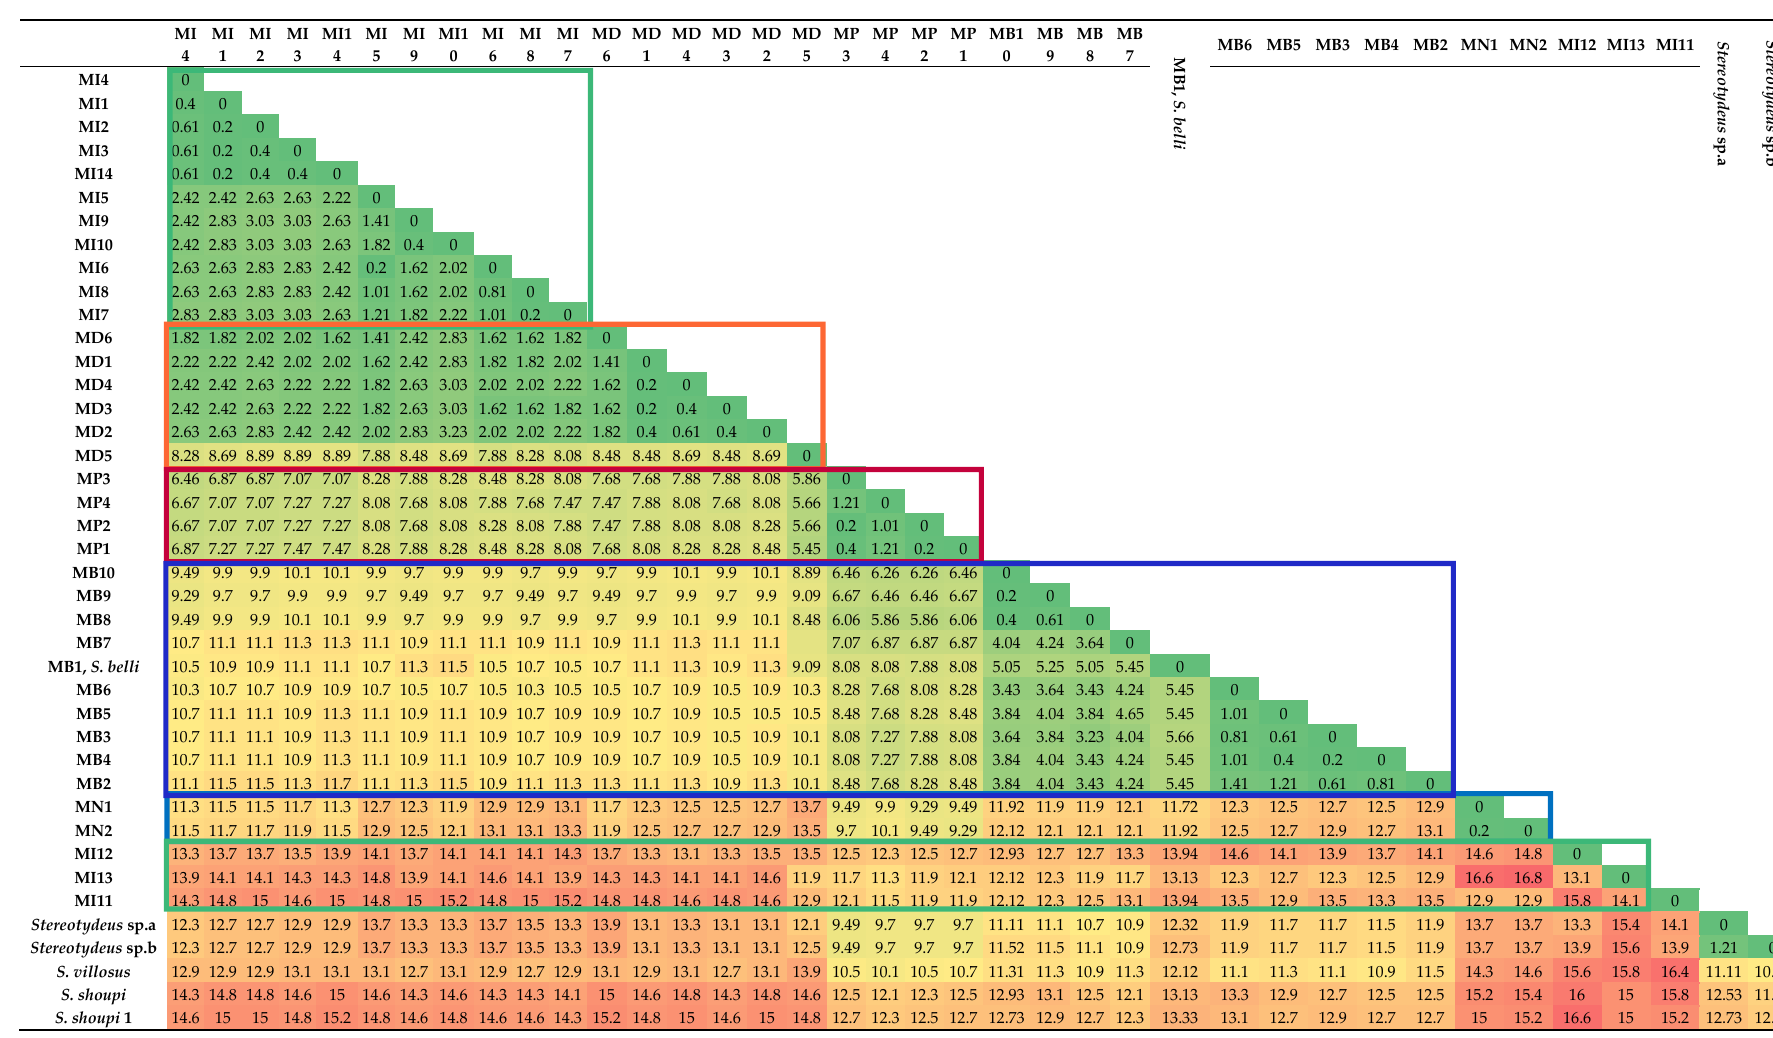
Table 6. Matrix of percentage genetic distances between Stereotydeus cox1 sequences. Cells were colored in a gradient from green (0%-low divergence) to red (16.8%-high divergence) to facilitate interpretation (see Table 5 for the haplotype